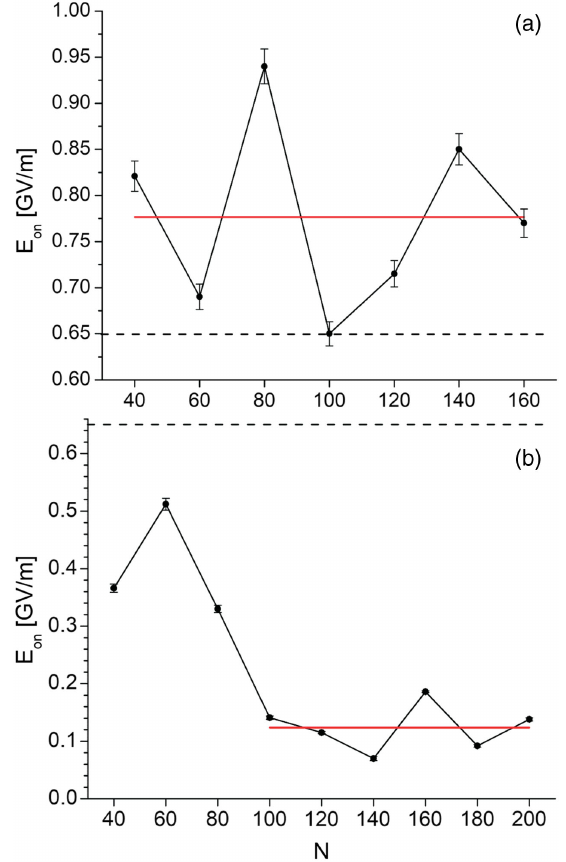
¼ , measured by I on FE for the initial surfaces for on